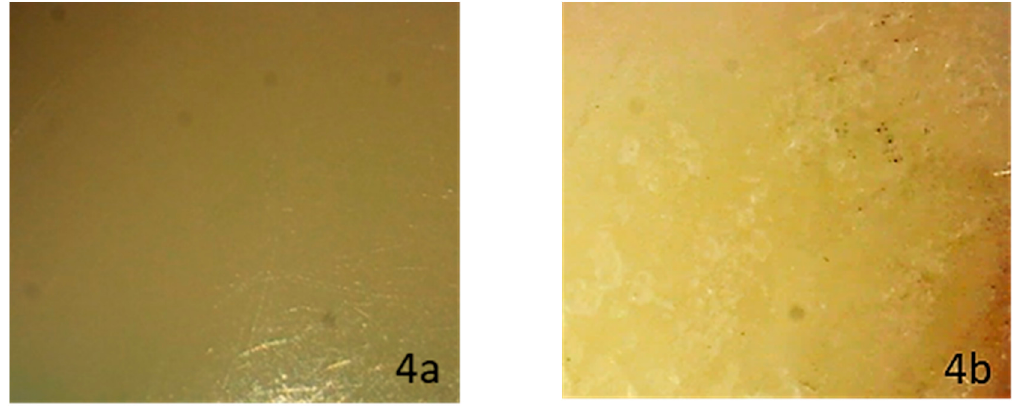
Figure 3. Stereomicroscopic evaluation shows sound enamel surface before ceramic bracket bonding ( 3a ), while it reveals visible area of localized enamel loss after laser debonding ( 3b ).